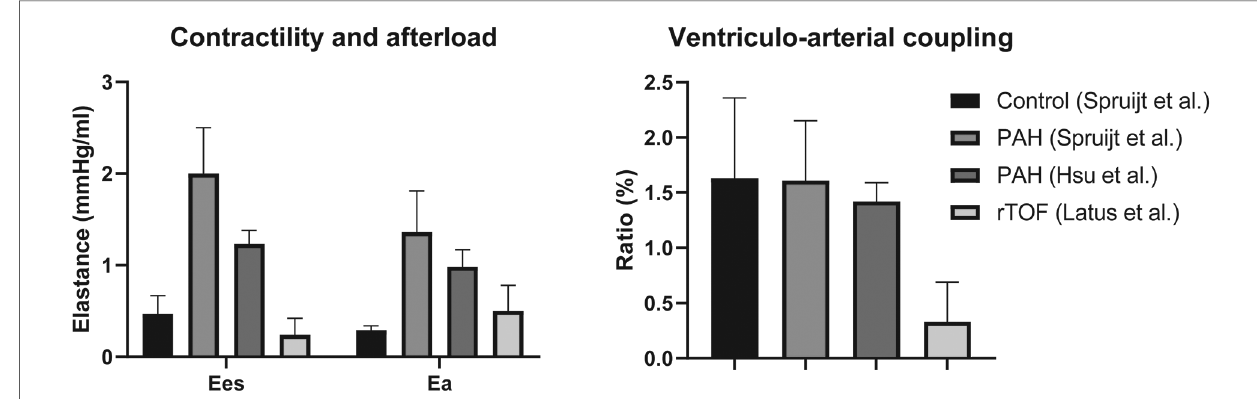
FIGURE 3 Comparison of contractility, afterload and ventriculo-arterial coupling in patients with pulmonary arterial hypertension and repaired tetralogy of Fallot. Ea, effective arterial elastance; Ees, end-systolic elastance; PAH, pulmonary arterial hypertension; rTOF, repaired tetralogy of Fallot. Spruijt et al. (39); Hsu et al. (38); Latus et al.